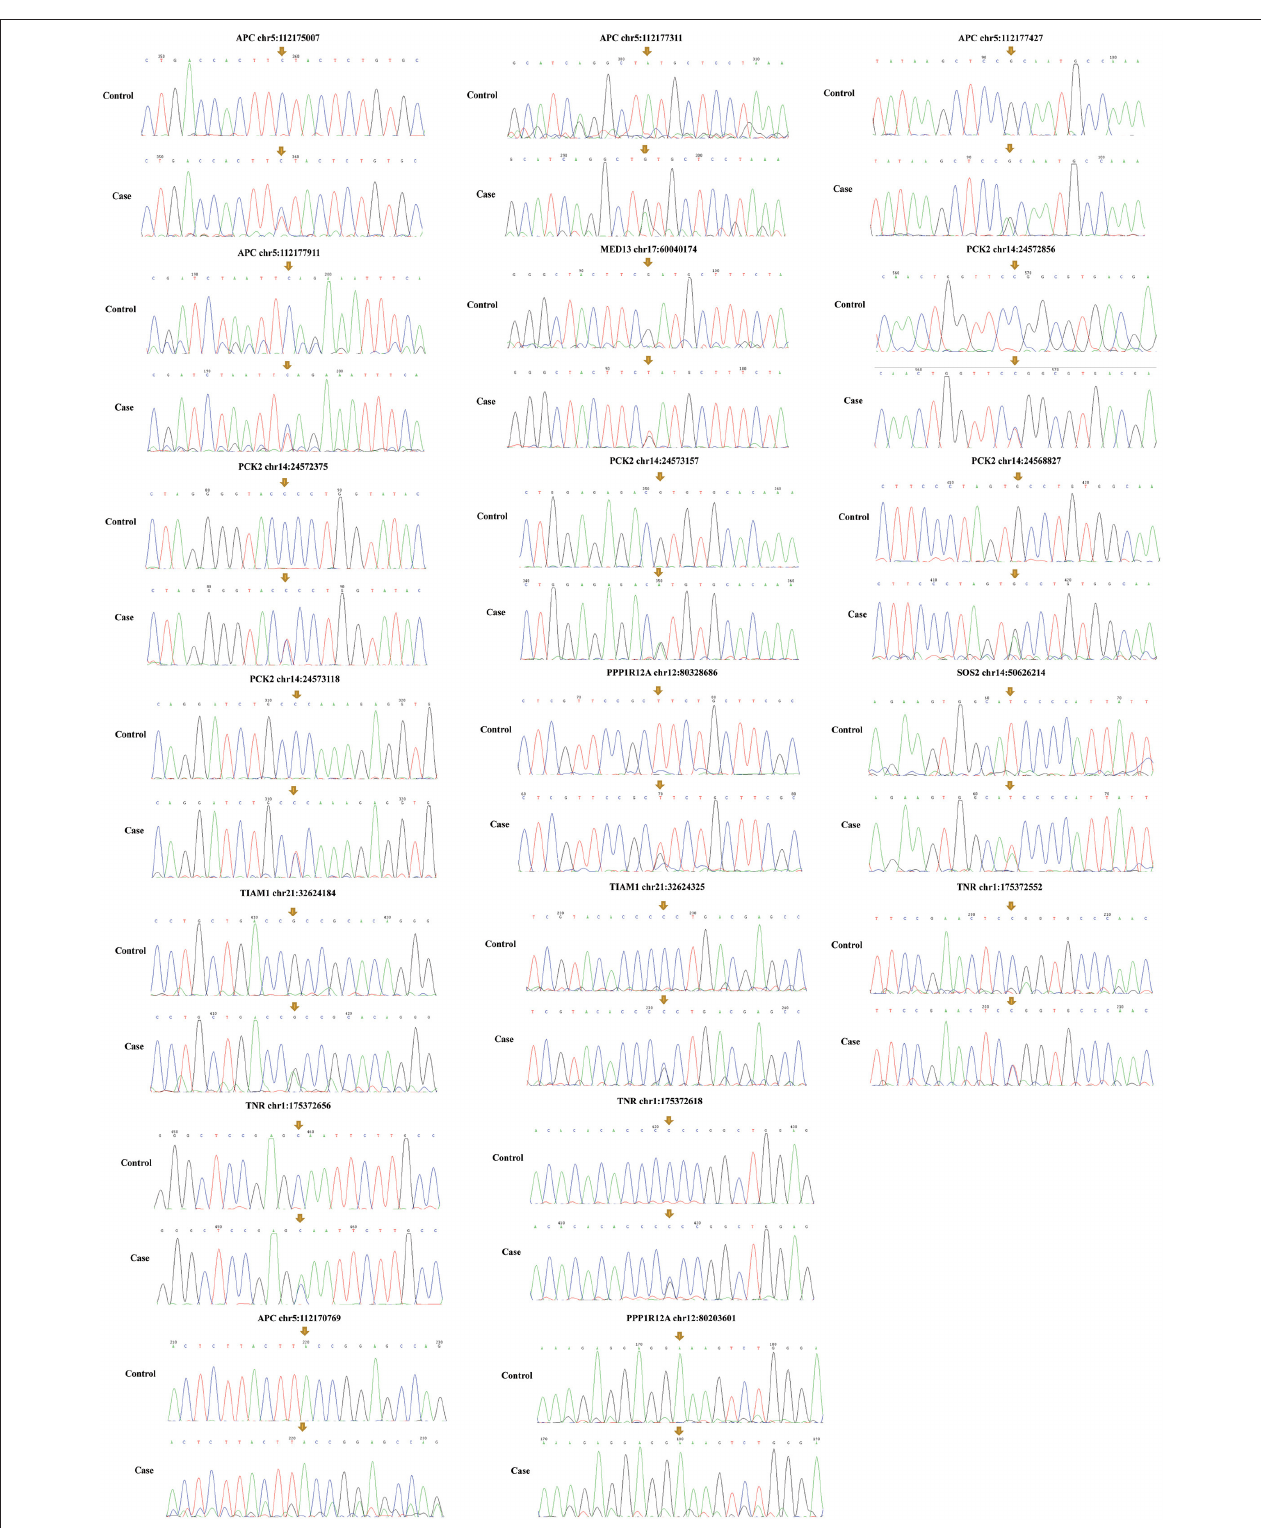
FIGURE 5 | Mutation validation of seven genes with 19 SNPs. Only two SNPs ( APC chr5:112170769 and PPP1R12A chr12:80203601) were not validated successfully. The yellow arrows represent the sites of SNPs.